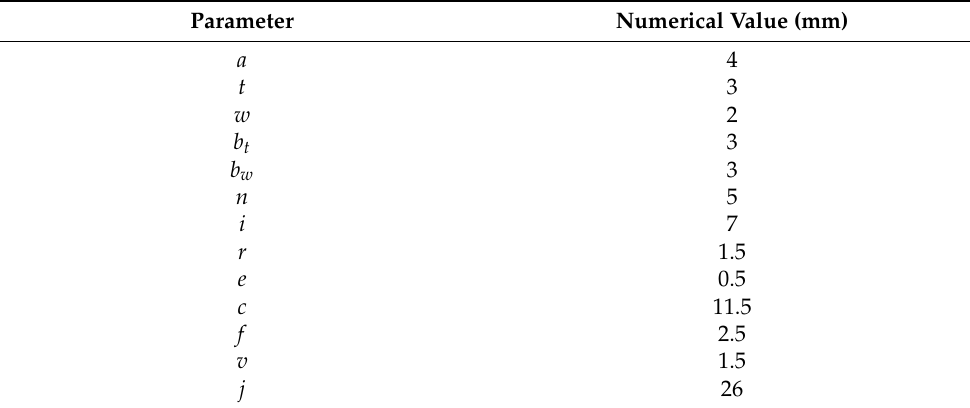
Table 1. Parameters of FBG three-dimensional accelerometer.